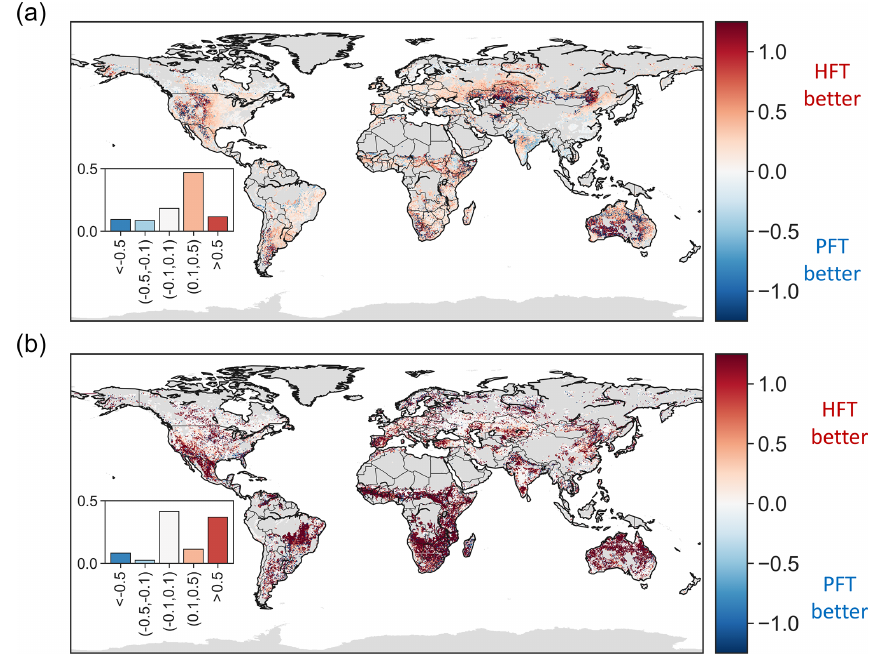
Figure 8. Normalized root mean square error (nRMSE) of estimated (a) ET and (b) VOD, using traits averaged by plant PFTs minus those using traits averaged by HFTs. The insets show the areal frequency of the nRMSE difference.